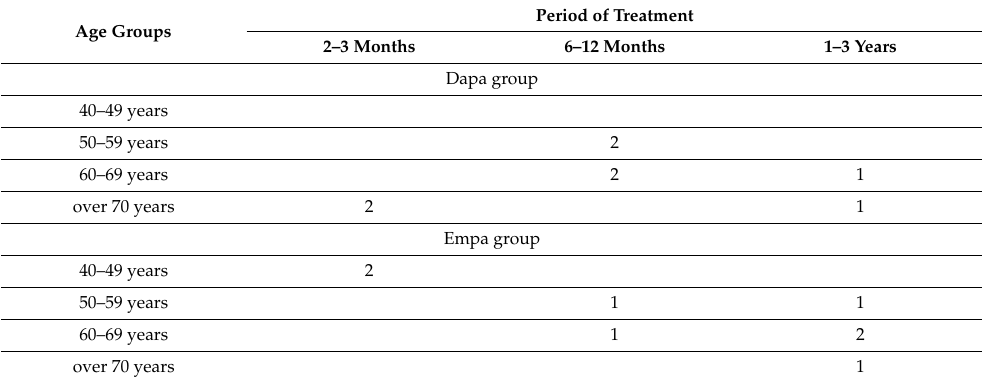
Table 1. Treatment duration until